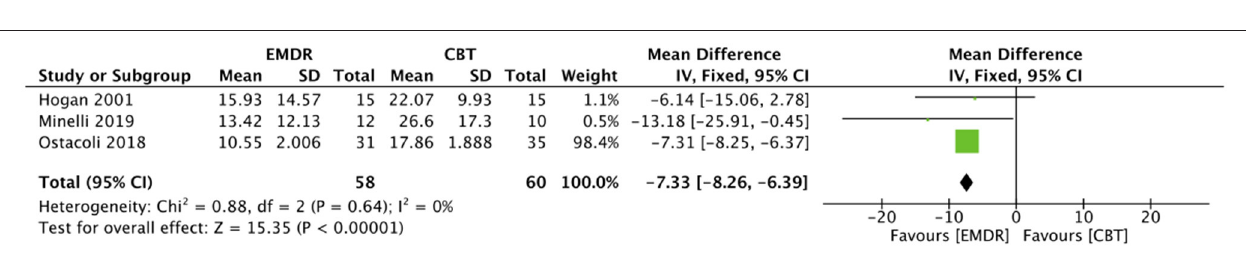
FIGURE 5 | Forest plots of meta-analyses EMDR vs. “No Intervention” control on remission. EMDR, eye movement desensitization and reprocessing.